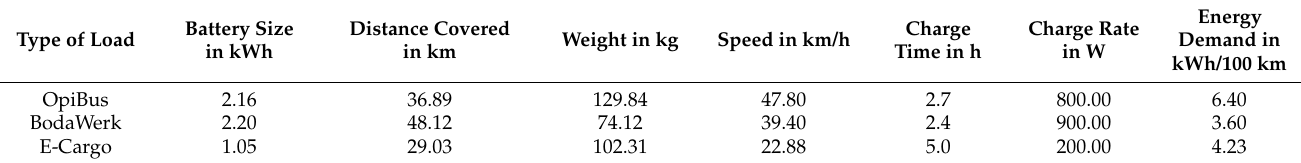
Table 4. Summary of electric bike measurement results.